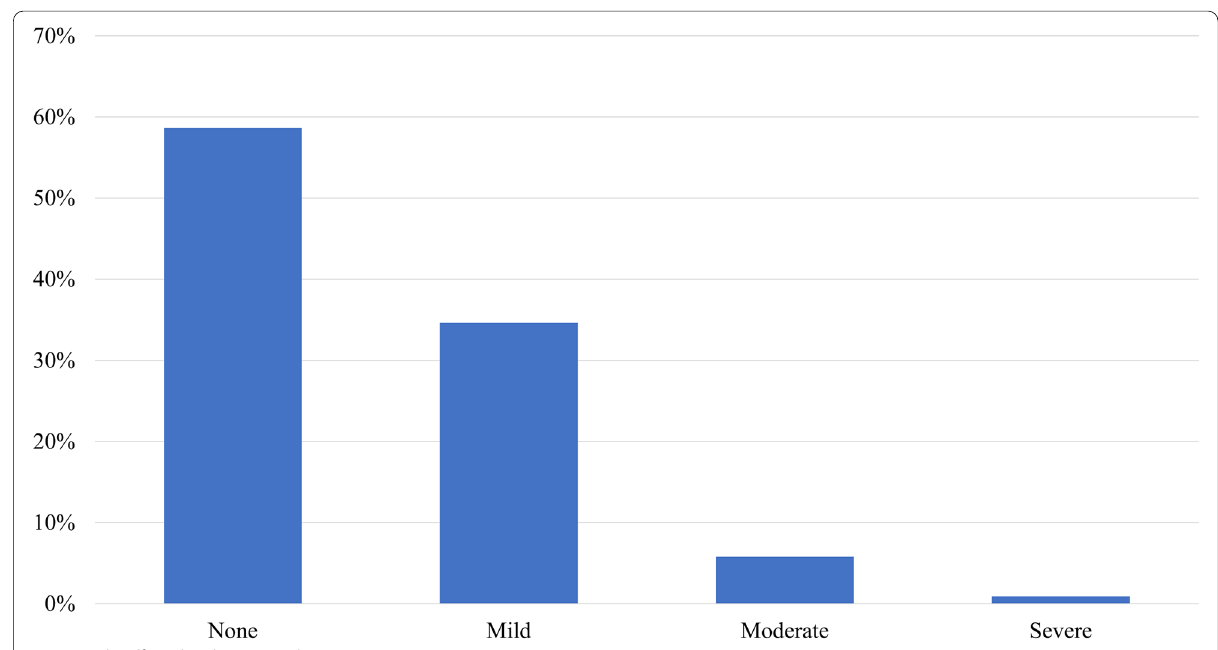
Fig. 2 Side effect distribution and severity